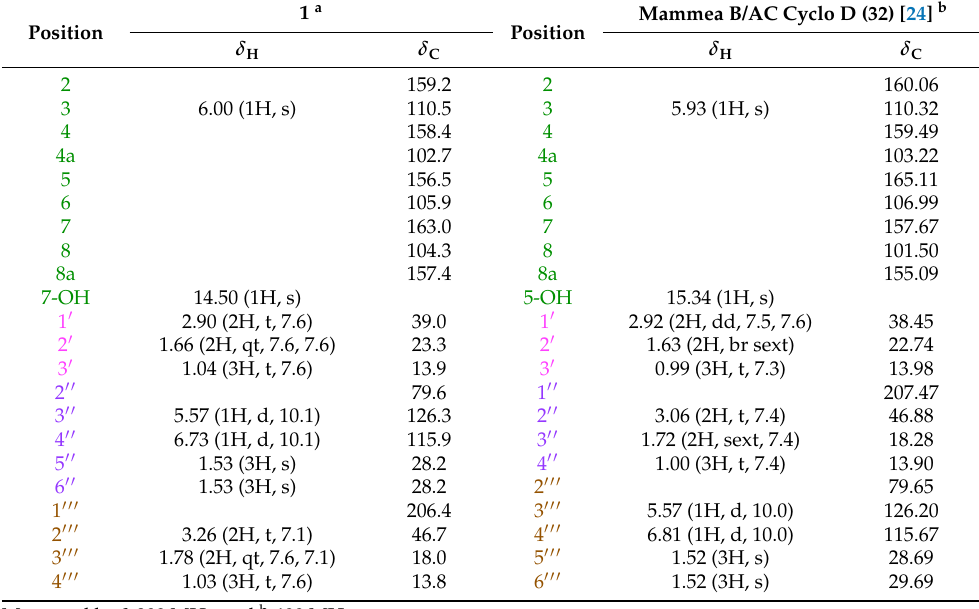
Measured by a 800 MHz and b 400 MHz.